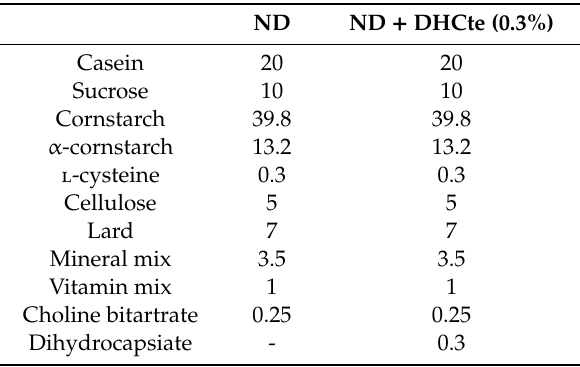
Table 1. Composition of the experimental diets (%).